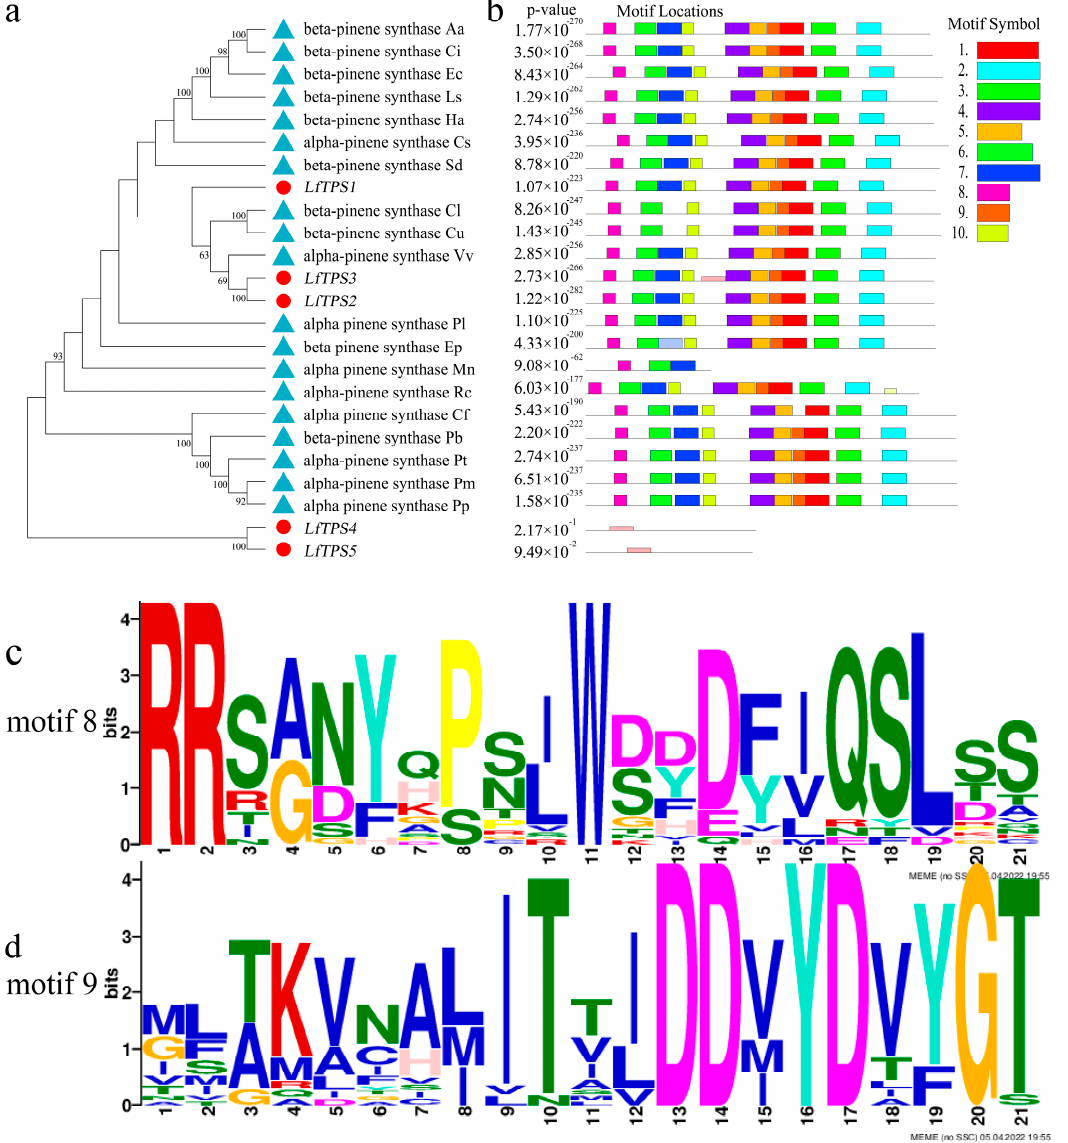
Figure 5. Phylogenetic analysis and correlation analysis of terpene synthases (TPSs). ( a ) Phylogenetic analysis of amino acid sequences of TPS in L. formosana along with other characterized TPS plants. The TPSs identified in this study are marked with red dots. ( b ) Comparison of TPS found in the L. formosana motif; ( c , d ) main motifs.